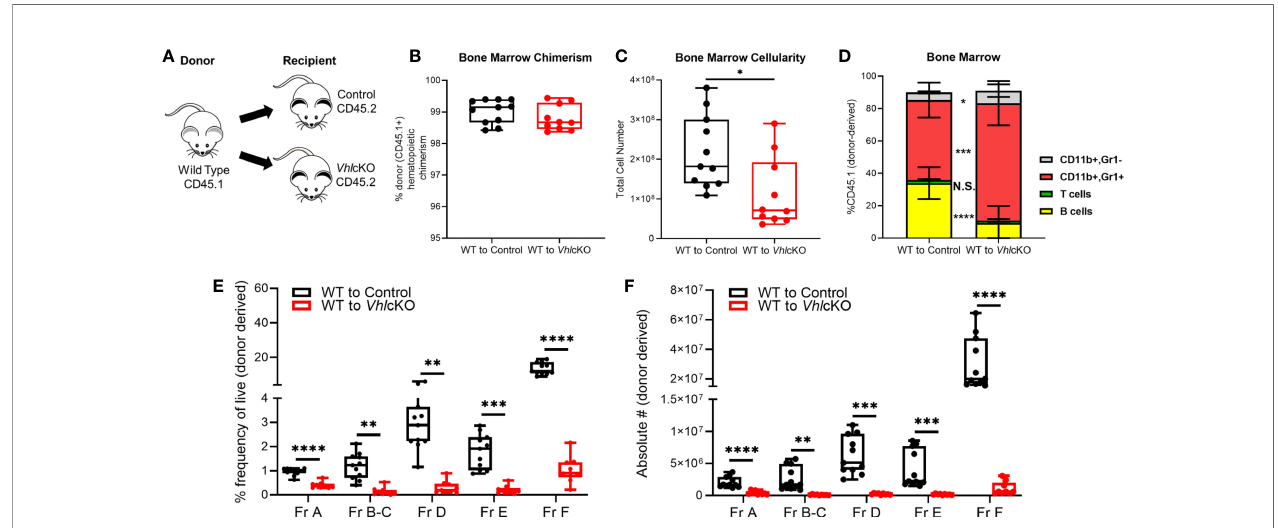
FIGURE 4 | Altered B cell development in WT ! Vhl cKO hematopoietic chimeras, demonstrating a cell-extrinsic effect of the Vhl -deleted osteolineage cells on B cell development. Mice were transplanted at 10 weeks of age and were analyzed 16 weeks post-transplantation. (A) experimental scheme; (B) donor (CD45.1) chimerism; (C) bone marrow cellularity; (D) frequency of lineage cells in bone marrow; (E) B cell frequency and (F) absolute number of B cell developmental stages at 16 weeks post-transplant. p<0.05*, p<0.01**, p<0.001***, p<0.0001**** two-tailed Student ’ s t-test. N.S., not statistically signi fi